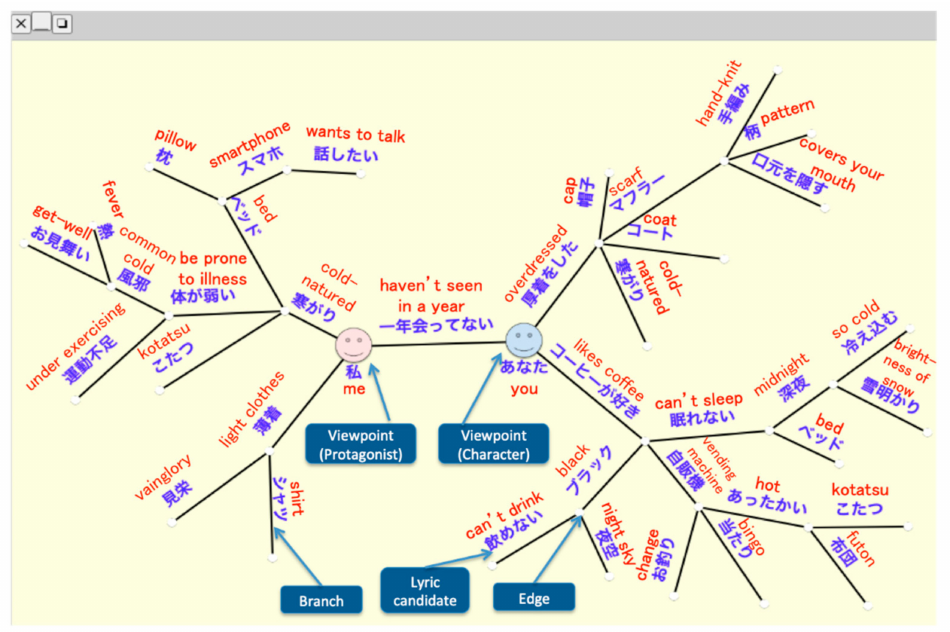
Figure 1. LAM window. (The blue texts next to the branches are the Japanese lyric keywords entered by the authors. The authors added the names of each element in white on dark blue, the arrows, and the English translations of the lyric keywords in